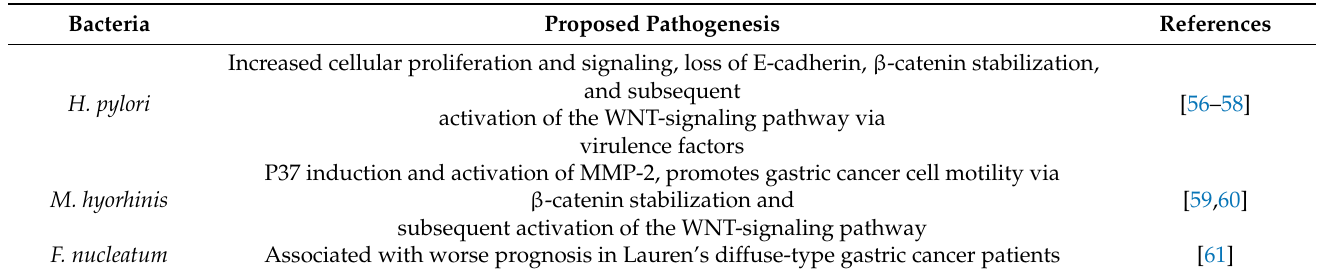
Table 2. Overview of bacteria associated with gastric